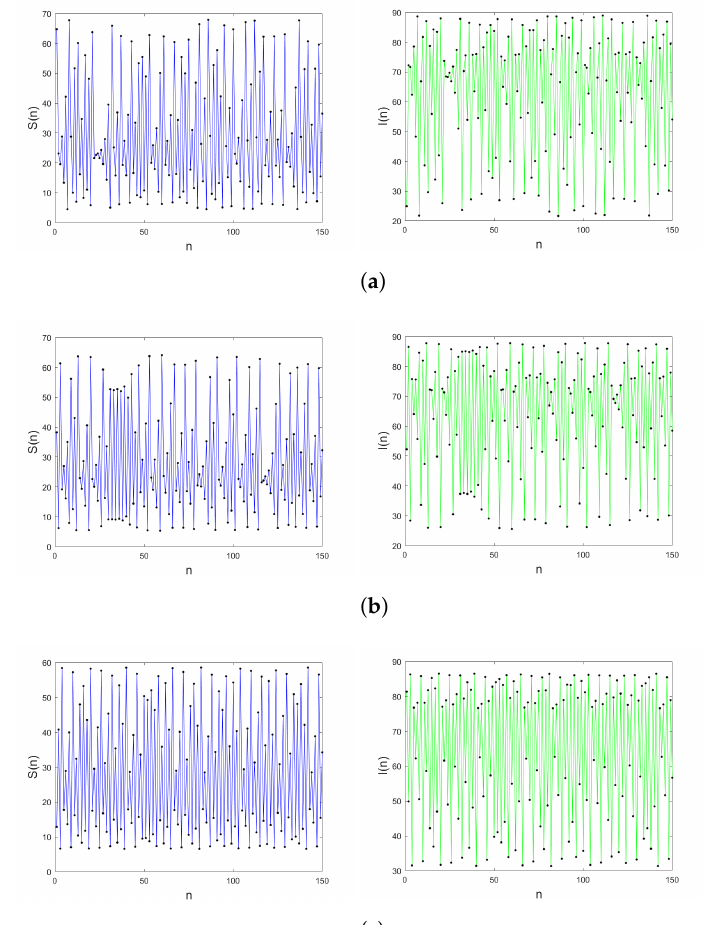
Figure 4. Time evolution of states for ( a ) γ = 0.89, ( b ) γ = 0.93, and ( c ) γ = 1.